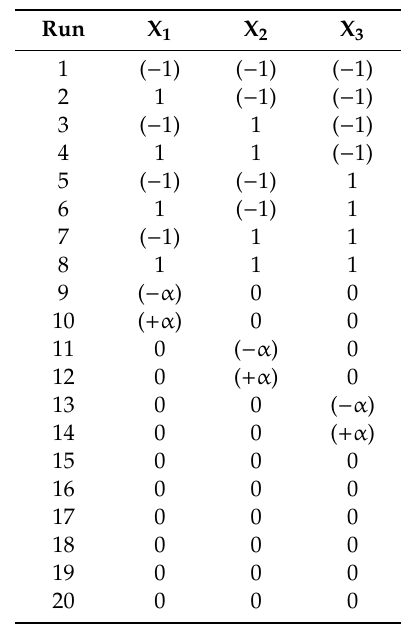
Table 2. Central composite design of coded